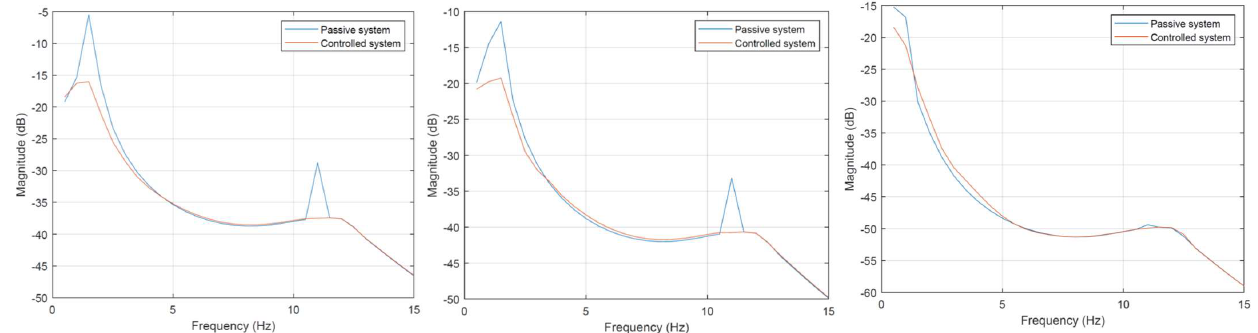
Figure 12. Vibration transmissibility characteristics for asymmetrical excitation of the front axis— right wheel delayed by π/2, relative to the left. Displacement of the center of mass—left characteristic, pitch angle—central characteristic, roll angle—right characteristic.